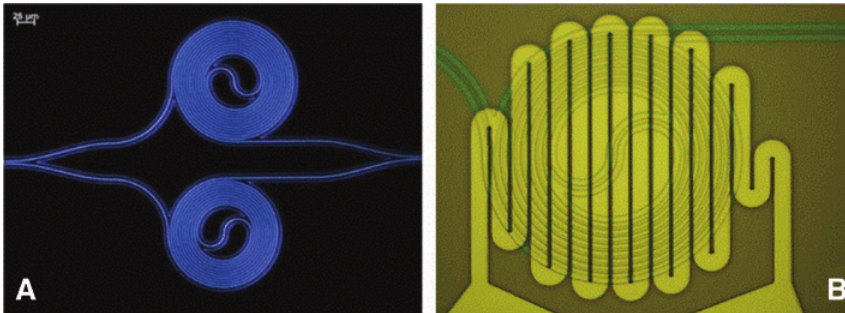
Figure 9: Mid-IR thermo-optic modulator. Top-view optical microscope image of (A) a spiral-arm MZI thermo-optic modulator in SOI and (B) one arm of the spiral MZI with metal heaters [144] (© 2014